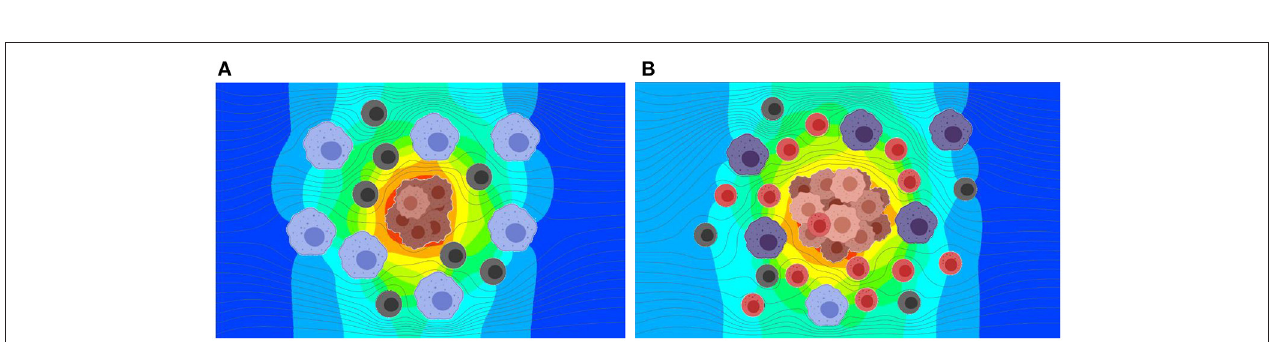
FIGURE 6 | Results from the simulation of interstitial fluid flow and exosome concentration in TME at two stages in tumor growth. Exosomes produced by the tumor cells at a constant rate are carried by the interstitial fluid flow and diffused based on the concentration gradient. (A) Predicted exosome concentration in an early stage. (B) Predicted exosome concentration in a later stage. The predicted concentration of exosomes is ∼ 3.5 times greater for the later stage as compared to the early stage.